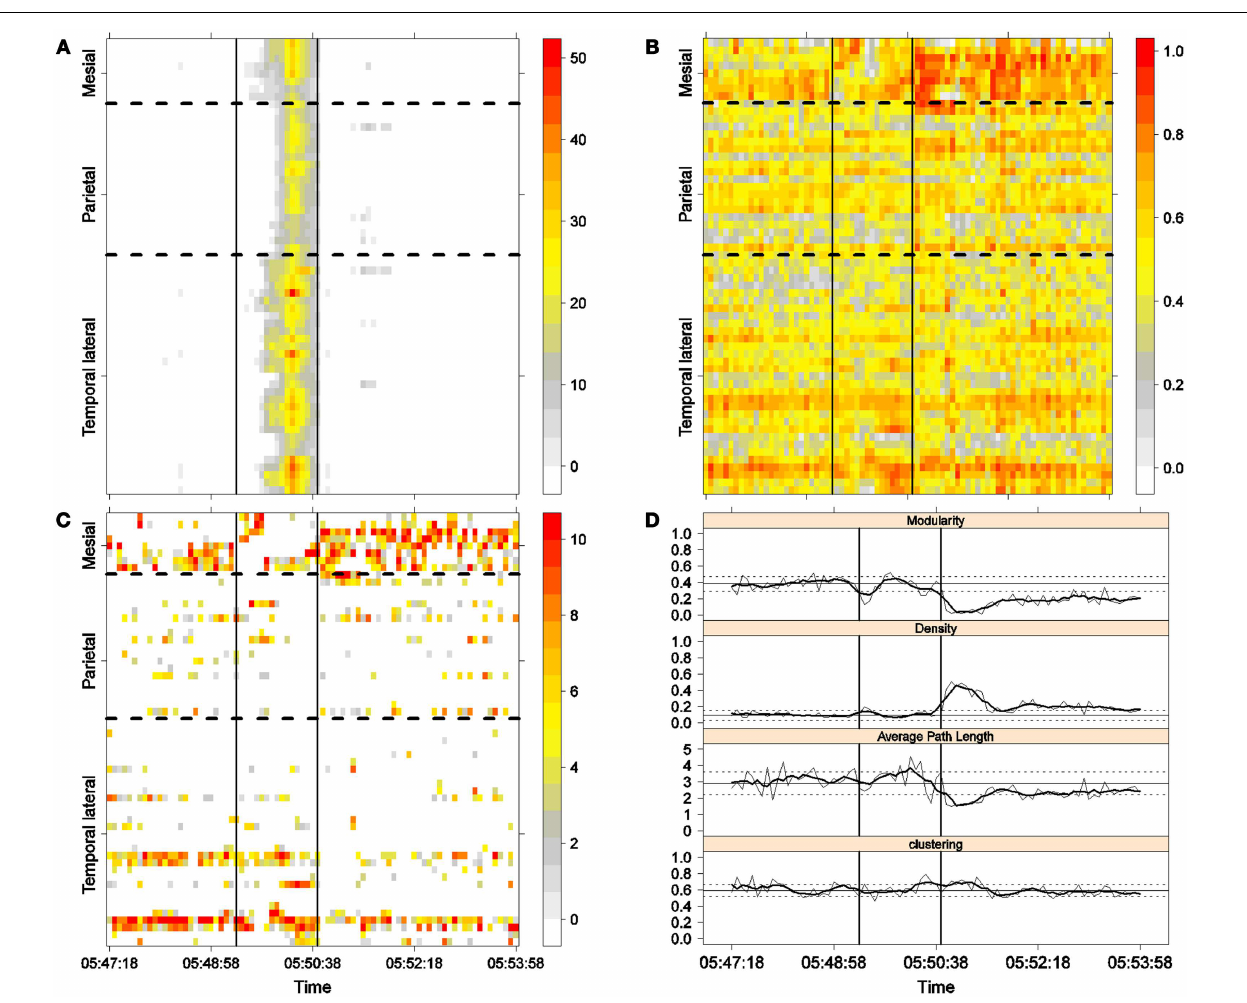
standard deviations of the corresponding measures during the interictal stage. The calculated values for each epoch are indicated by a thin, solid line, and the moving average of five consecutive epochs is shown with a thick, solid